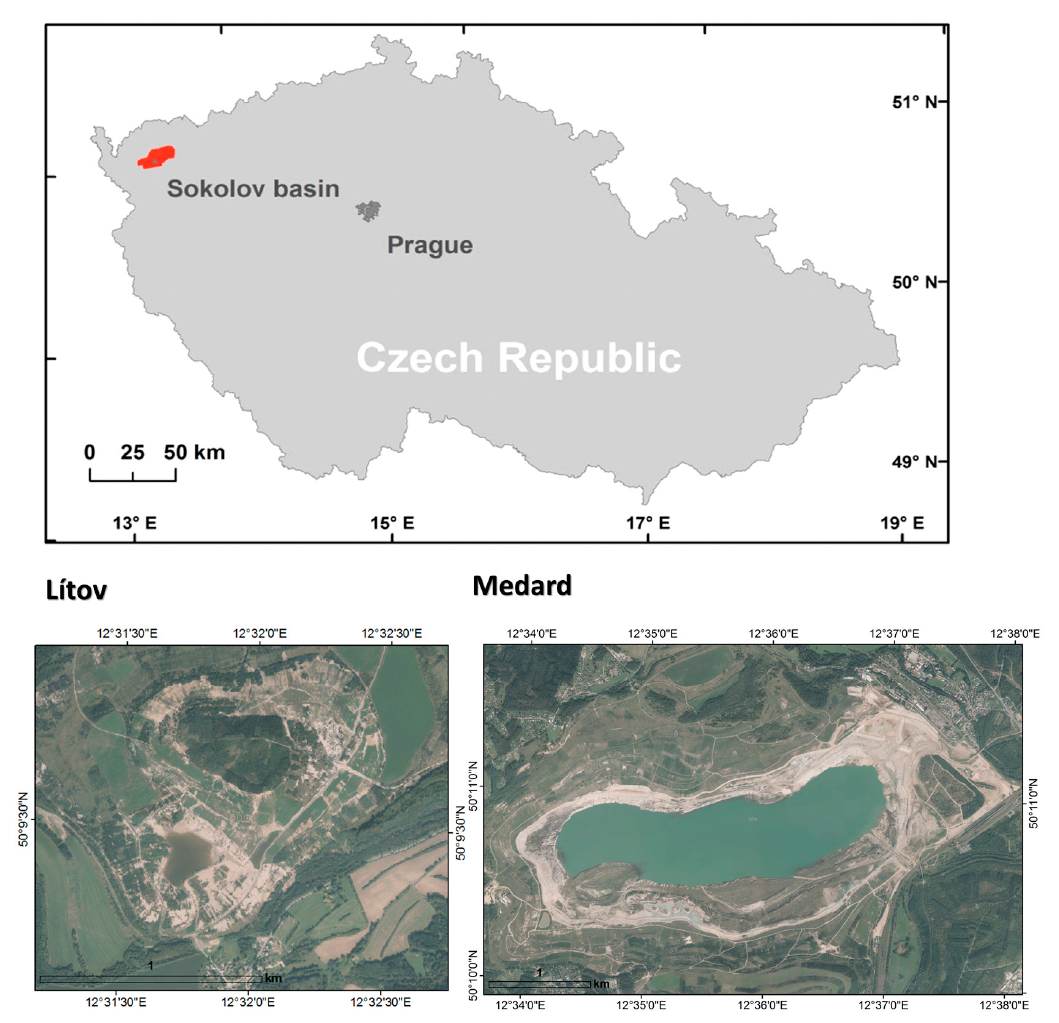
Figure 1. Geographic position of the two sites under study: L í tov dump and Medard Lake, Sokolov basin, Czech Republic.